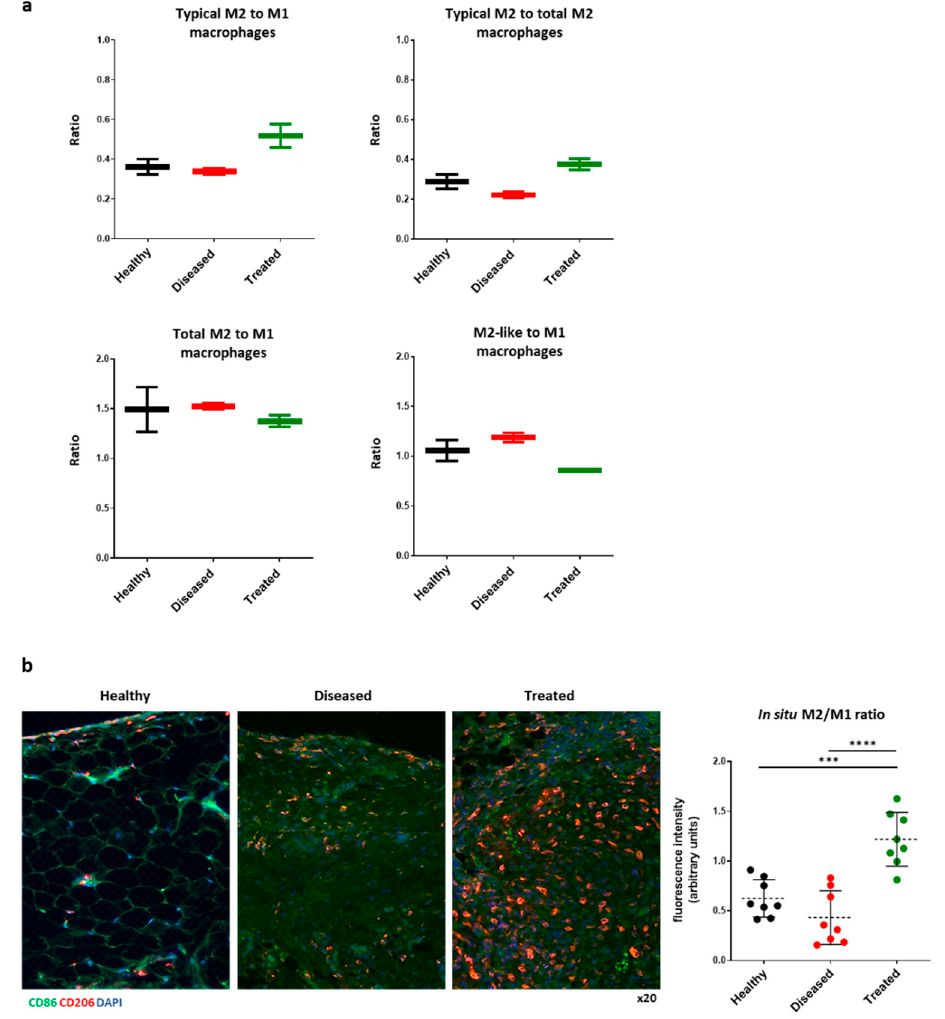
Figure 4. ( a ) Typical M2/M1, typical M2/total M2, total M2/M1, and M2-like/M1 ratios for each sample group based on single-cell RNA-sequencing macrophage clustering (total M2 = typical M2 + M2-like proportions). ( b ) Immunophenotyping profiling for CD86 (M1) and CD206 (M2) macrophages within the IFP tissue in all three groups tested (healthy, diseased, treated). In situ, IFP-MSC treated group showed M2/M1 significantly higher ratio than healthy and diseased groups ( *** p < 0.001 and **** p < 0.0001 ). Statistical analysis was performed using one-way ANOVA for multiple comparison. Table 3. Cell count and proportion in each defined myeloid cell population for each sample group. Healthy Diseased Treated Differences between Groups (z-Statistics) Healthy versus Healthy versus Diseased versus Cluster Cell Count Proportion Cell Count Proportion Cell Count Proportion Diseased Treated Treated